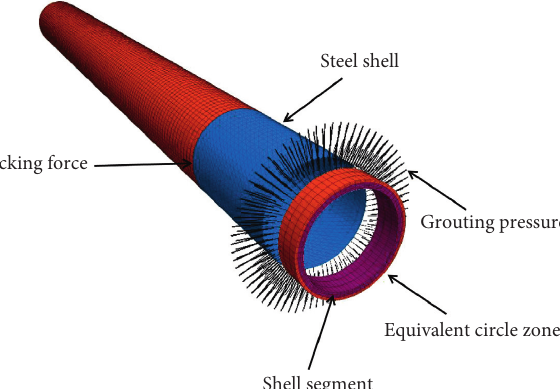
Figure 21: Shield tunnelling